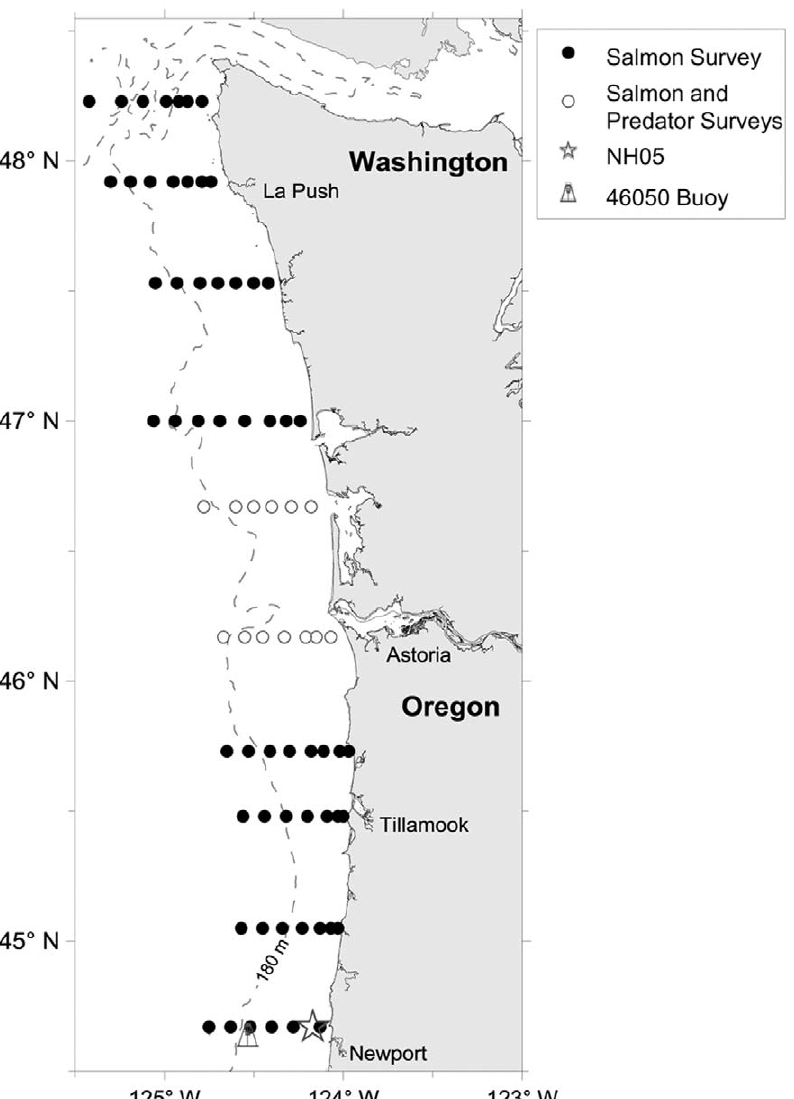
Figure 1. Map of the study region. Sampling locations are shown for the Salmon and Predator Surveys, the NH05 site, and Buoy 46050.